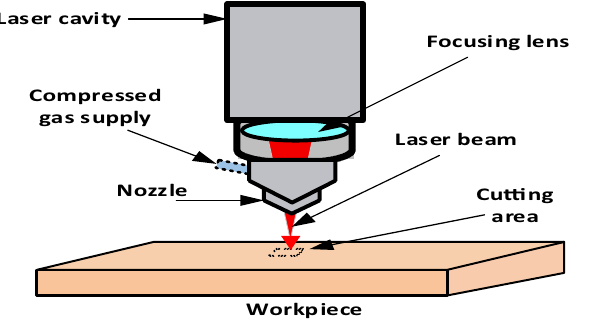
Fig. 1 Schema of classical gas-assisted laser cutting